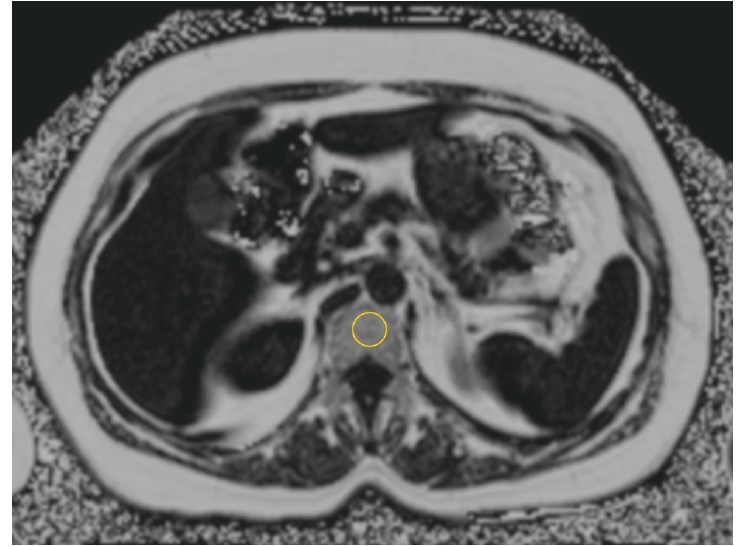
Figure 1. Assessment of bone marrow fat content in first lumbar vertebral body in the anterior part, medium level, avoiding vessels and the anterior border on a proton density fat fraction (PDFF) map with one region of interest with 2.0 cm 2 (ROI, yellow circle).